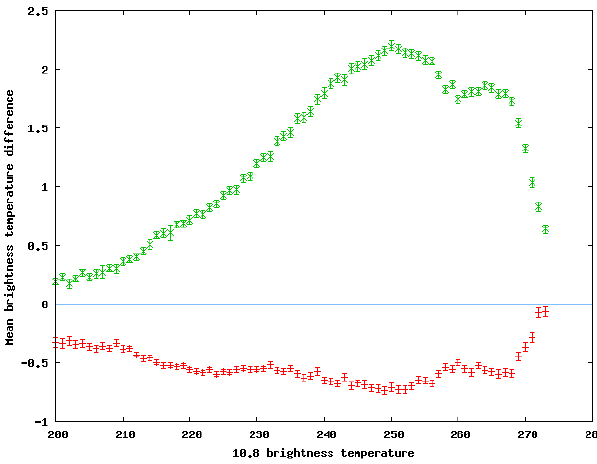
Figure 2.c. Difference of the mean value of 9.7 µm and 13.4 µm channels between non rainy and rainy Fig. 2c. Difference of the mean value of 9.7µm and 13.4µm chan- pixels plotted versus 10.8 µm brightness temperature in red and green respectively. Curves are plotted nels between non rainy and rainy pixels plotted versus 10.8µm with error-bars. Both scales are in Kelvin. brightness temperature in red and green respectively. Curves are plotted with error-bars. Both scales are in